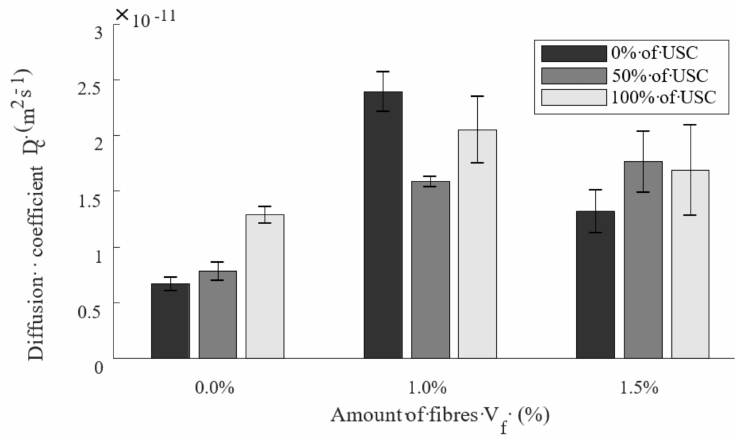
Figure 3. Results of diffusion coefficients at 461 days after concreting for all studied groups.